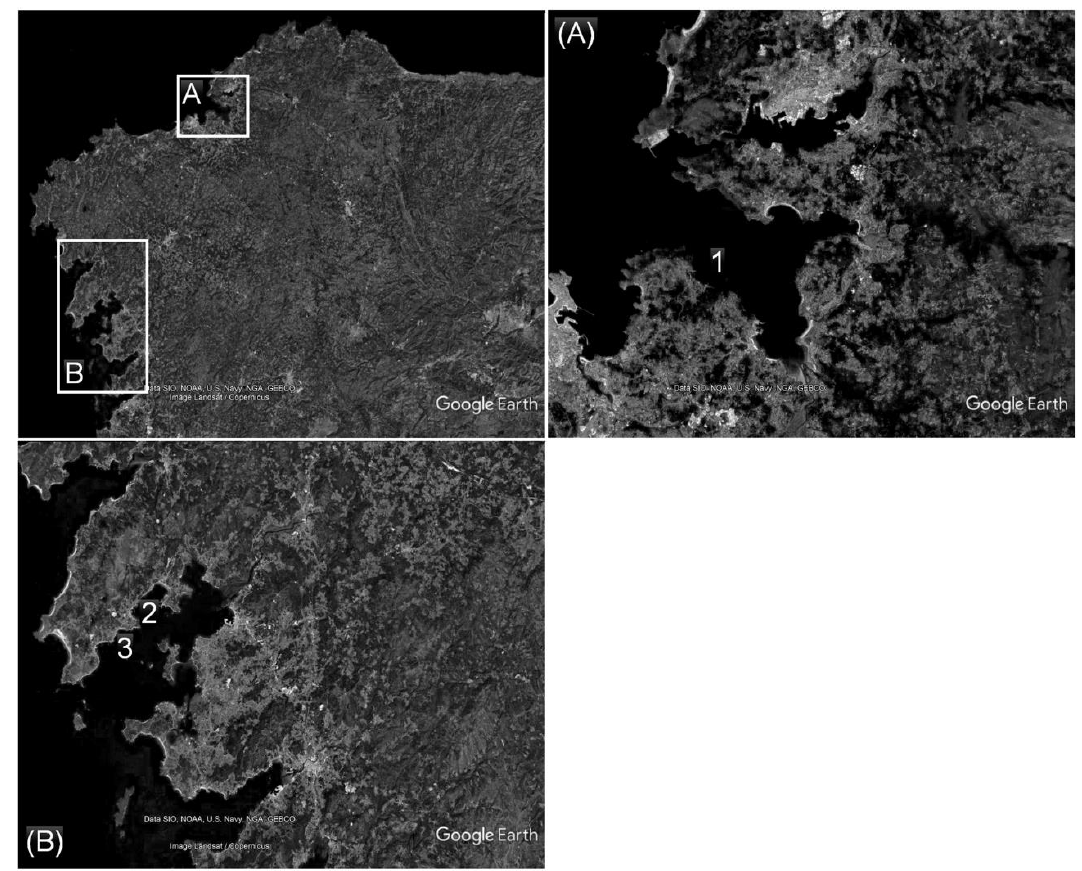
Figure 2. Map of Galicia (northwest Spain) with the sampling locations (1, 2, and 3) in Ría de Sada ( A ) and Ría de Arousa ( B ). Images (data SIO, NOAA, U.S. Navy, NGA, GEBCO; image Landsat/Copernicus) are from Google Earth.